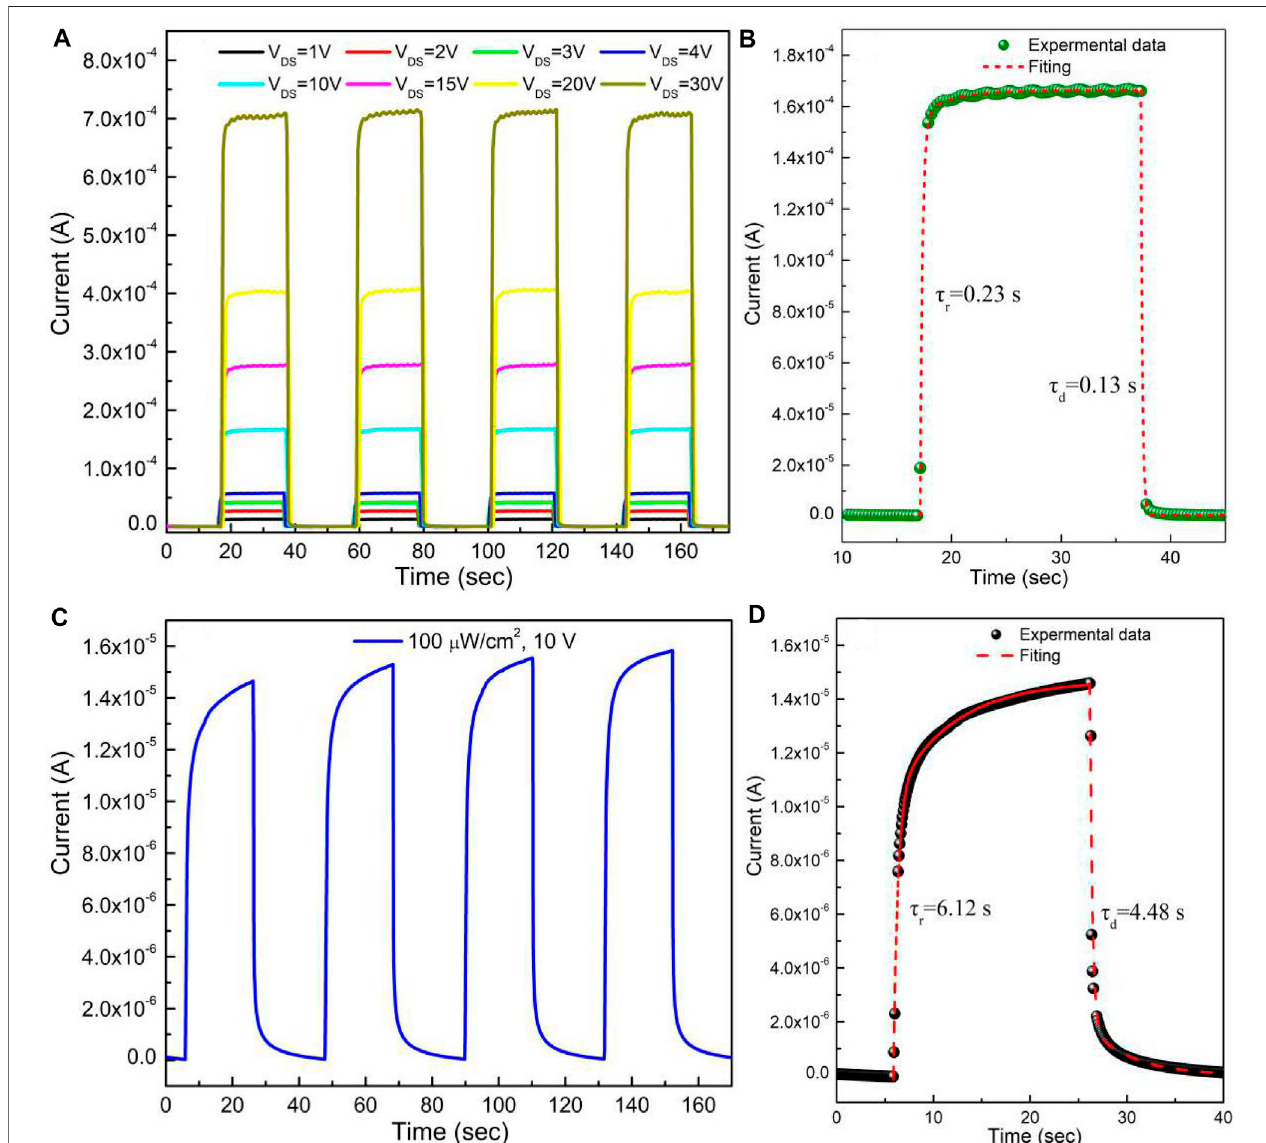
FIGURE 5 | (Color online) (A) Time-dependent photoresponse of the β -Ga 2 O 3 PD under a grain voltage V GS (cid:2) 10 V for V DS (cid:2) 1, 2, 3, 4, 10, 15, 20, and 30 V, respectively. (B) Experimental curve and fi tted curve of the rise and decay processes of the device for V DS (cid:2) 10 V. (C) Time-dependent photoresponse of the MSM structure PD without gate voltage. (D) Experimental curve and fi tted curve of the rise and decay processes of the MSM structure device.